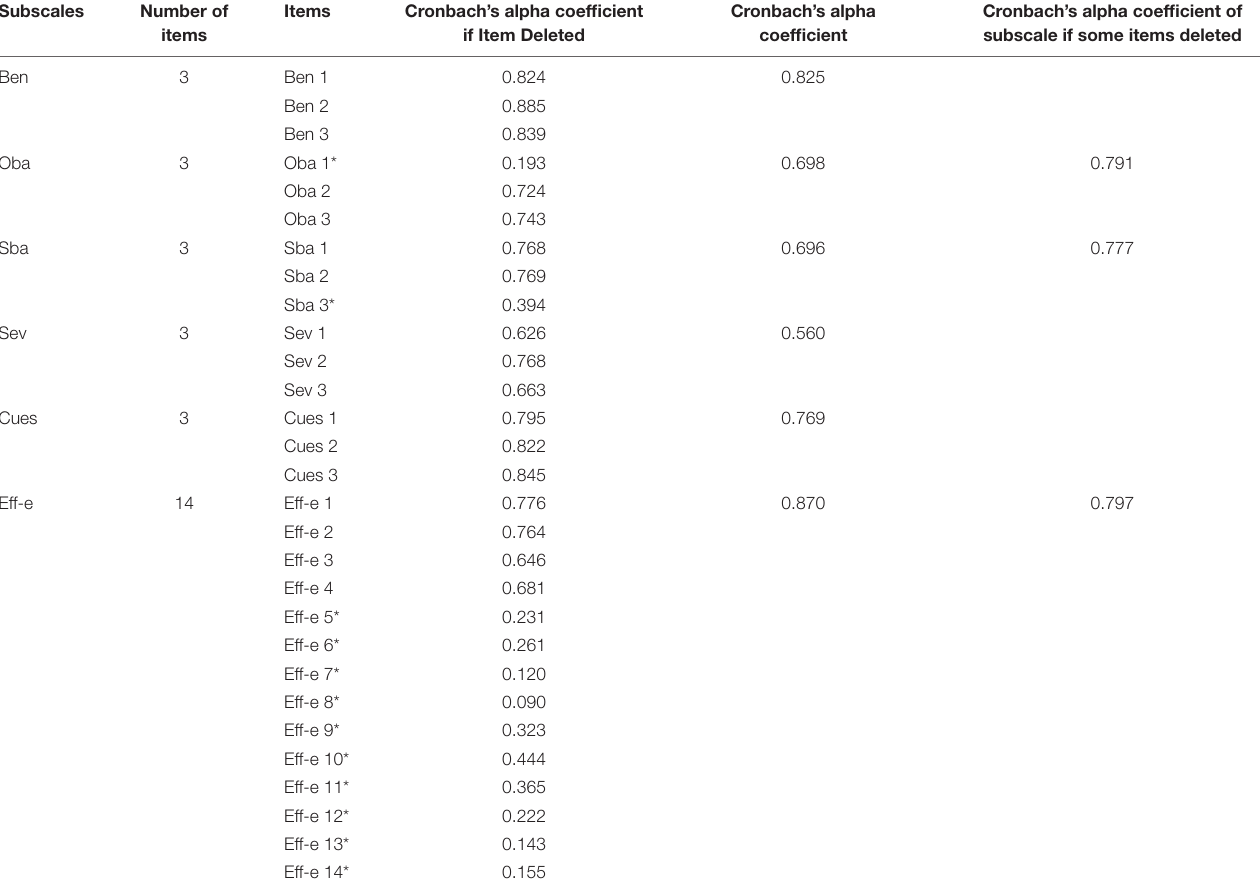
TABLE 2 | Reliability coefficients of subscales (Cronbach’s alpha coefficient).